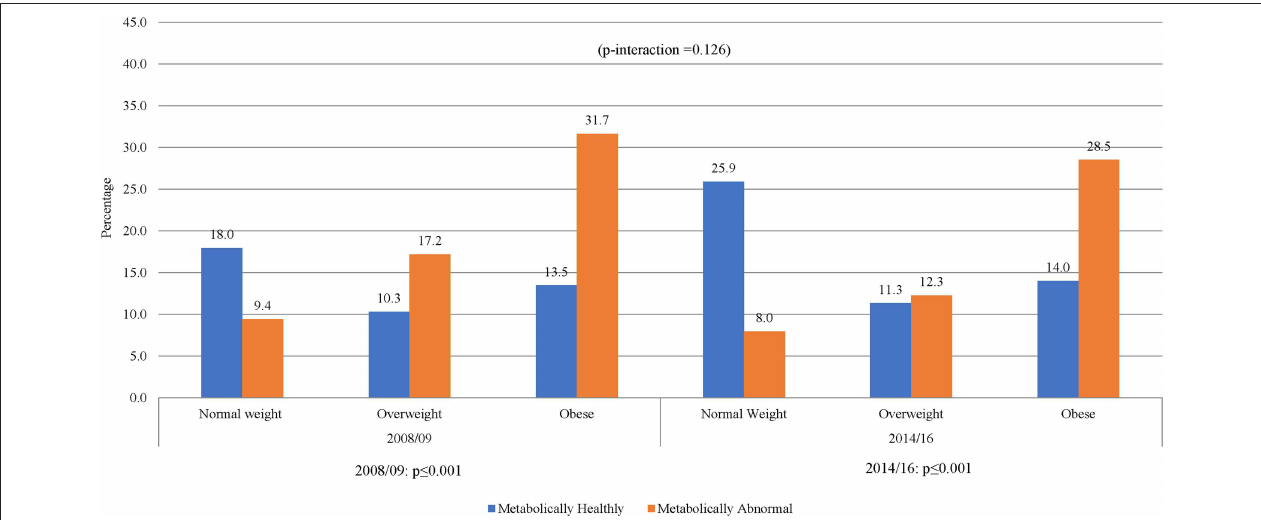
FIGURE 2 | Prevalence metabolic phenotype within BMI categories by year of study.